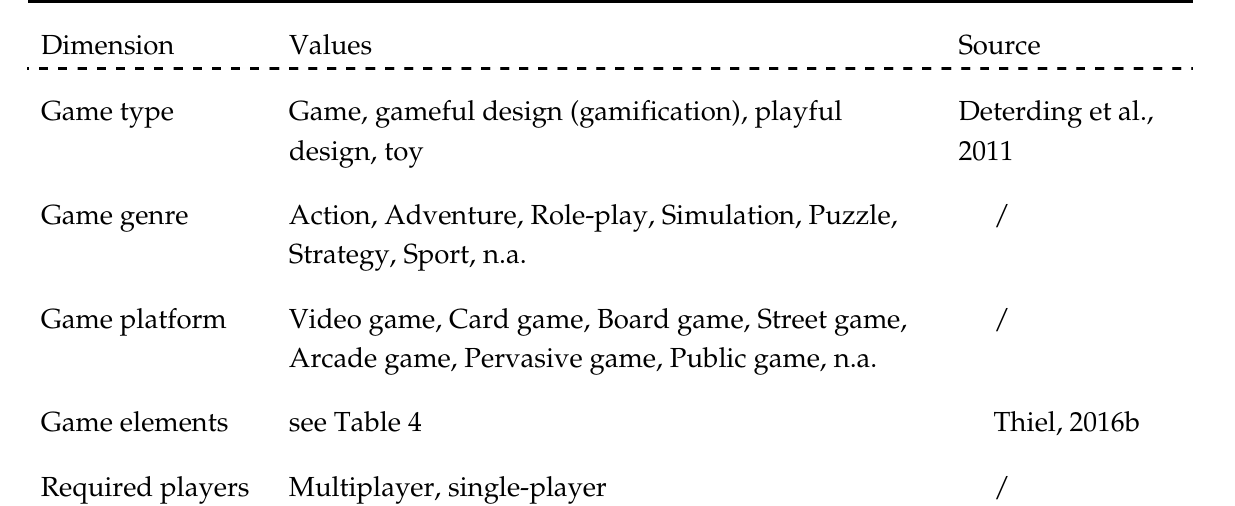
Deterding et al., 2011 /